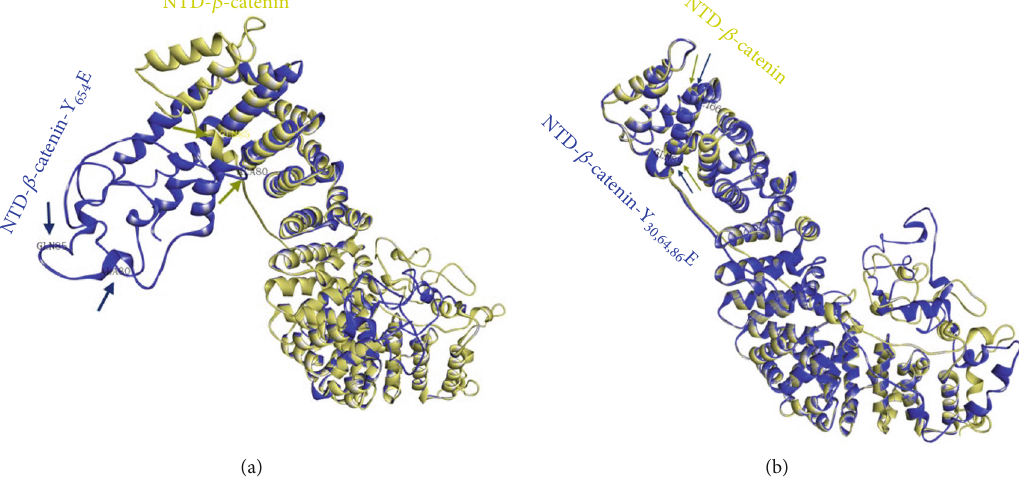
Figure 7: Molecular dynamics of Jak3-mediated phosphorylation sites in β -catenin [8]. Arrows (gold, β -catenin – WT; blue, β - catenin — Y654E) indicate the corresponding positions of Ala80, Gly85, and Val166 in the modeled proteins. Note that superimposed β - catenin – WT (gold) on Y30E, Y64E, and Y86E (blue) in (b) shows overlap of the positional markers Gly85 and Val166 in the structure of the protein, indicating a close resemblance in conformation of the NTD of β -catenin – WT and β -catenin – Y30E, Y64E, and Y86E and a reversal of orientation from β -catenin – Y654E in